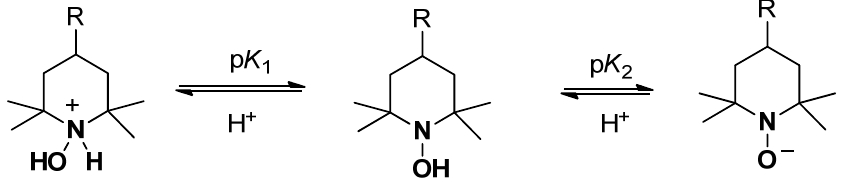
Scheme 3. Different forms of hydroxylamine, RN + HOH, RNO-H, RNO −